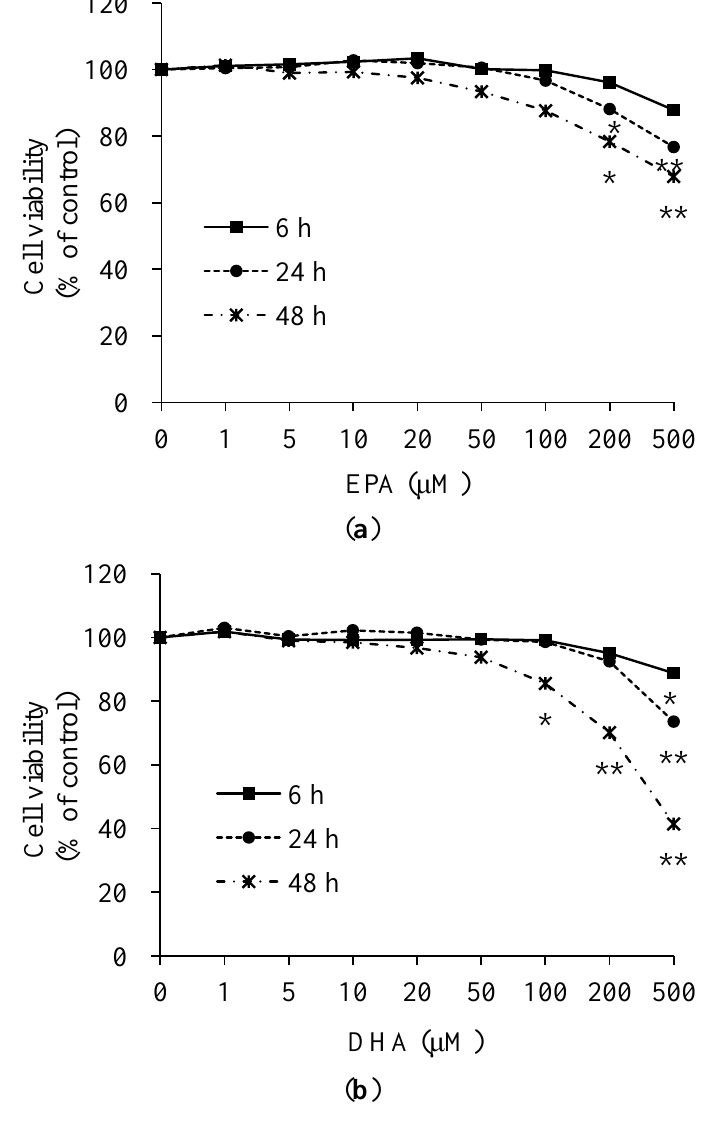
Figure 1. Effects of eicosapentaenoic acid (EPA) ( a ) and docosahexaenoic acid (DHA) ( b ) on the cell viability of muscle cells. Cells were treated with 0 (control), 1, 5, 10, 20, 50, 100, 200, or 500 µM of EPA or DHA, and incubated for 6, 24, or 48 h. Cell viability was determined using the WST-8 assay. Values are expressed as mean ± SE ( n = 3) of three independent experiments. * P < 0.05 and ** P < 0.01 versus control